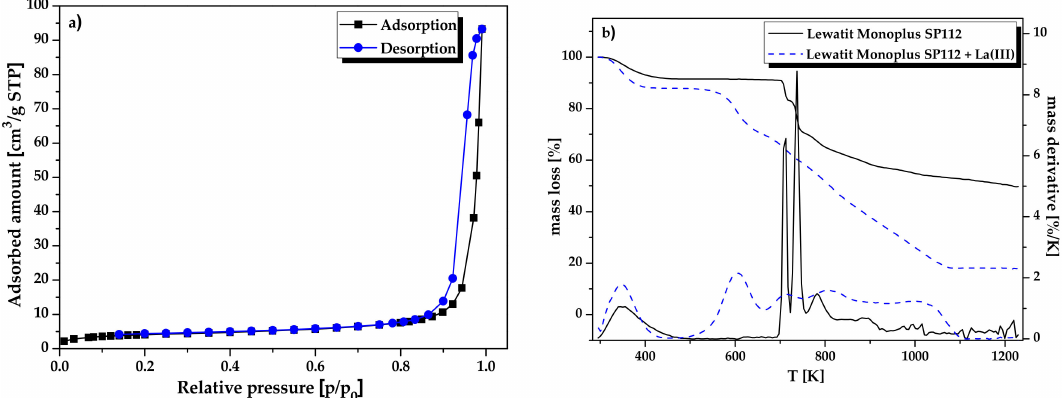
Figure 4. ( a ) Low-temperature adsorption / desorption nitrogen isotherm and ( b ) TG / DTG curves of Lewatit Monoplus